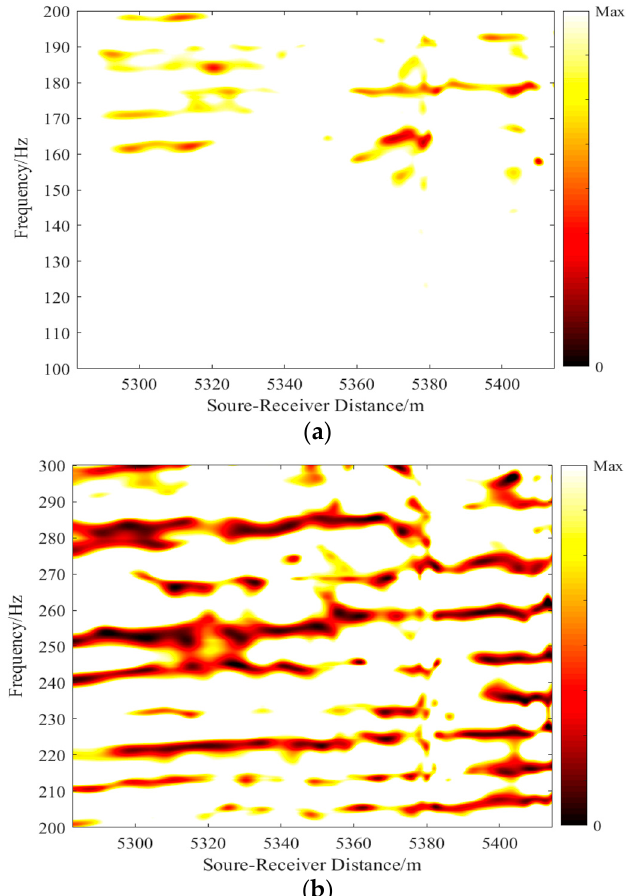
Figure 3. Experimentally obtained sound intensity images corresponding to ( a ) 100–200 Hz and ( b ) 200–300 Hz frequency bands.